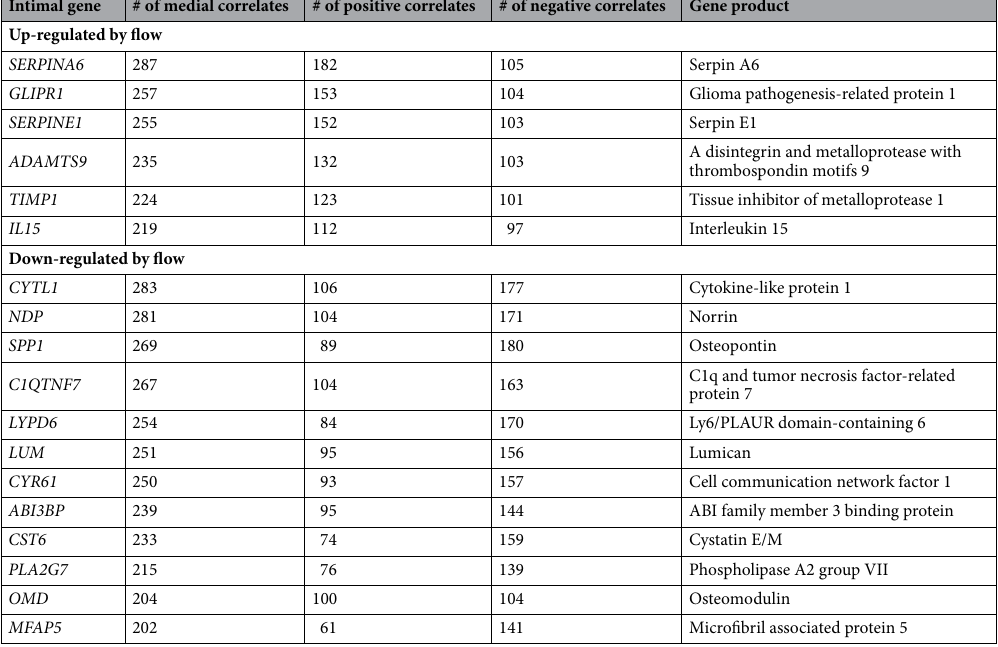
Table 2. Highly correlated intimal DEGs with extracellular products. For each Intimal DEG encoding an extracellular product, the number of medial DEGs whose expression significantly correlated was determined. The intimal DEGs with > 200 medial correlates are listed. The upper portion of the table shows genes that were upregulated by increased flow (at both the BA and BT) and the bottom genes were decreased by flow (at both the BA and